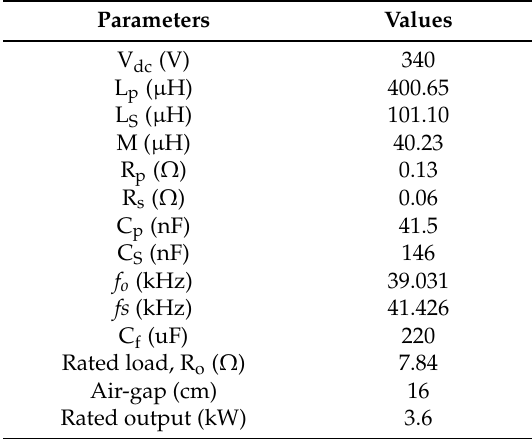
Table 1. Parameters of Series-Series Compensated IPT System.